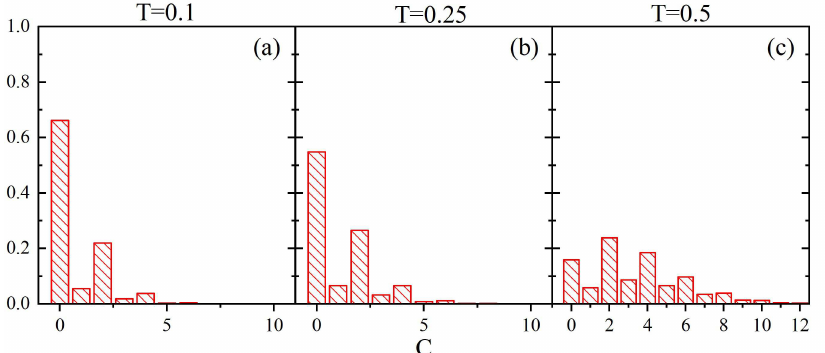
Figure 8. Empirical probability distributions ρ ( C ) : T = 0.1 ( a ), T = 0.25 ( b ) and T = 0.5 ( c ).